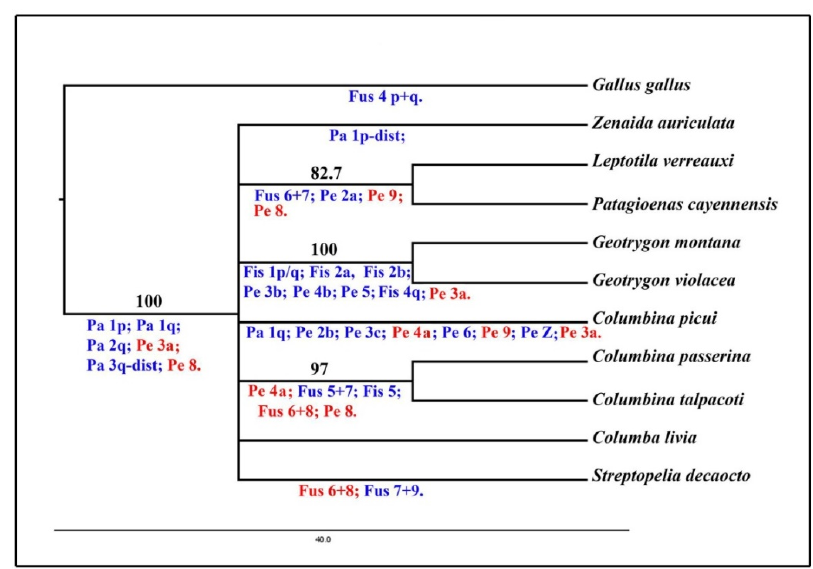
Figure 7. Phylogenetic analysis of maximum parsimony using PAUP based on chromosome rearrangements present in Columbidae species according to results obtained by whole chromosome painting with Gallus gallus and Zenaida auriculata probes and G ‐ banding. All rearrangement characters are mapped a posteriori and are shown below the branches. Characters in red indicate chromosome rearrangements shared for more than one branch (homoplasic characters). Black numbers above the branch indicate the bootstrap value with one thousand replicates.